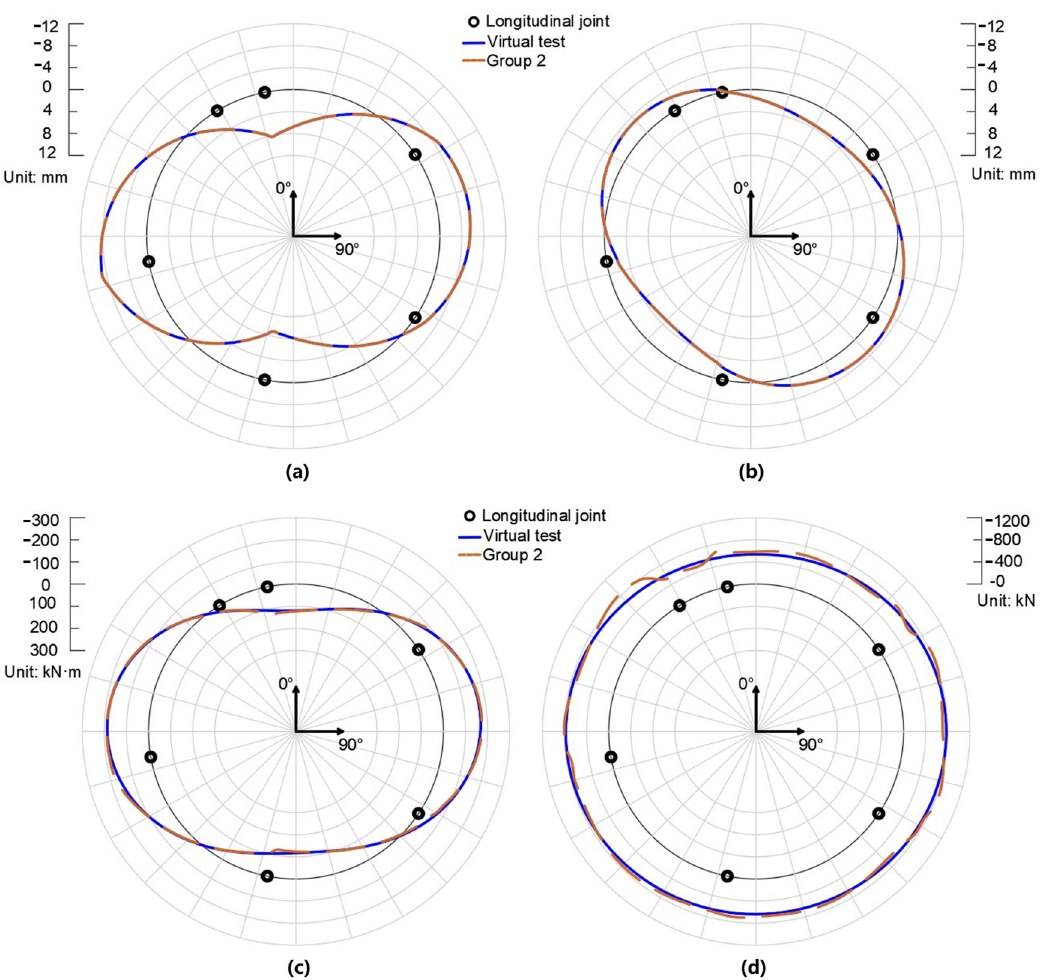
Figure 6. The radial displacement ( a ), tangential displacement ( b ), bending moment ( c ), and axial force ( d ) of virtual test and Group 2.